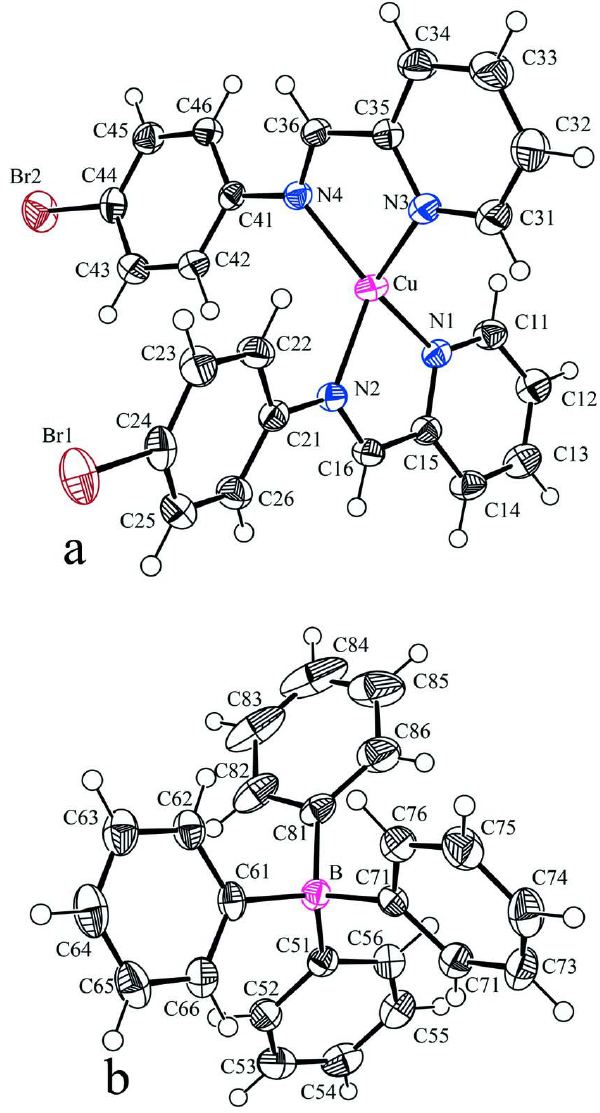
Crystal structure of the cation (a) and the anion (b) with labeling and thermal ellipsoids drawn at 50% the probability level. Hydrogen atoms are shown as spheres of arbitrary